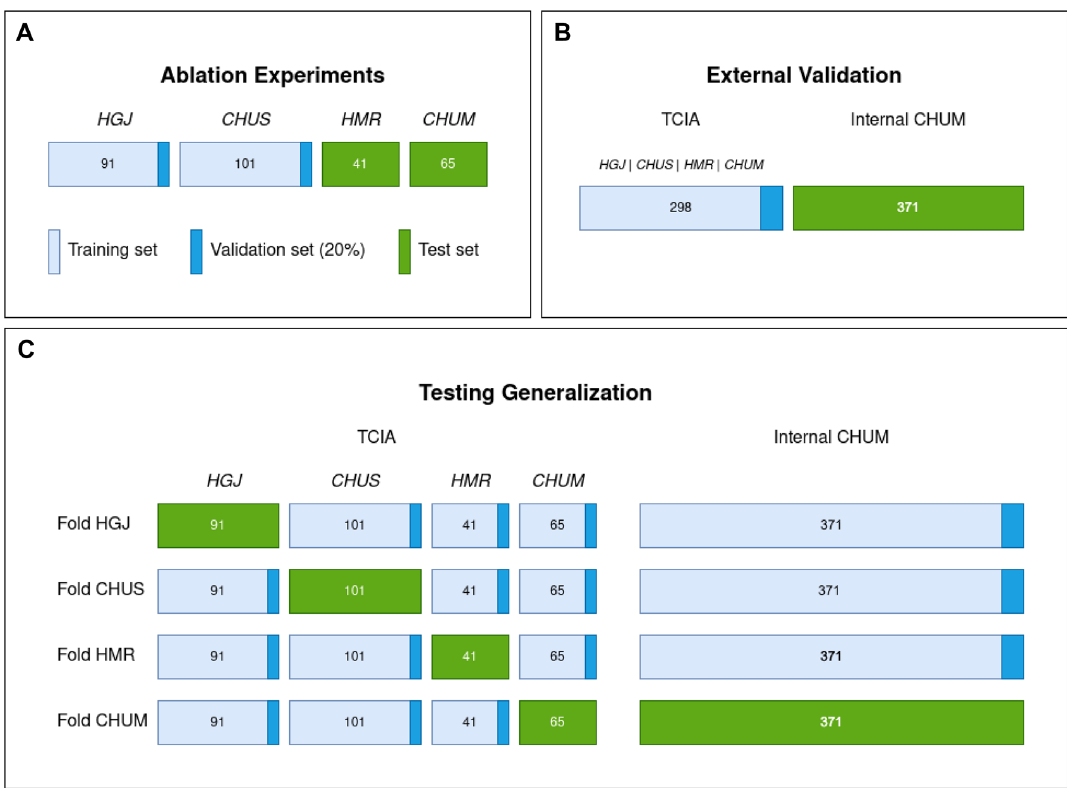
Figure 8. Data splitting strategies for model evaluation. The mean performance is reported across all five folds. ( A ) The training set are samples originating from CHUS and HGJ, with 20% held out as a validation set. The test set is composed of samples from CHUM and HMR. This split 30 is used for ablation experiments as well as comparison to previous literature. ( B ) 5-fold cross-validation over the entire dataset. This split is used to evaluate the novel Internal CHUM dataset. ( C ) Hold-one-institution-out cross-validation strategy where each source institution is held as a test set with the remaining samples used for training and validation. This split is used to test cross-institution generalization. Figure created with